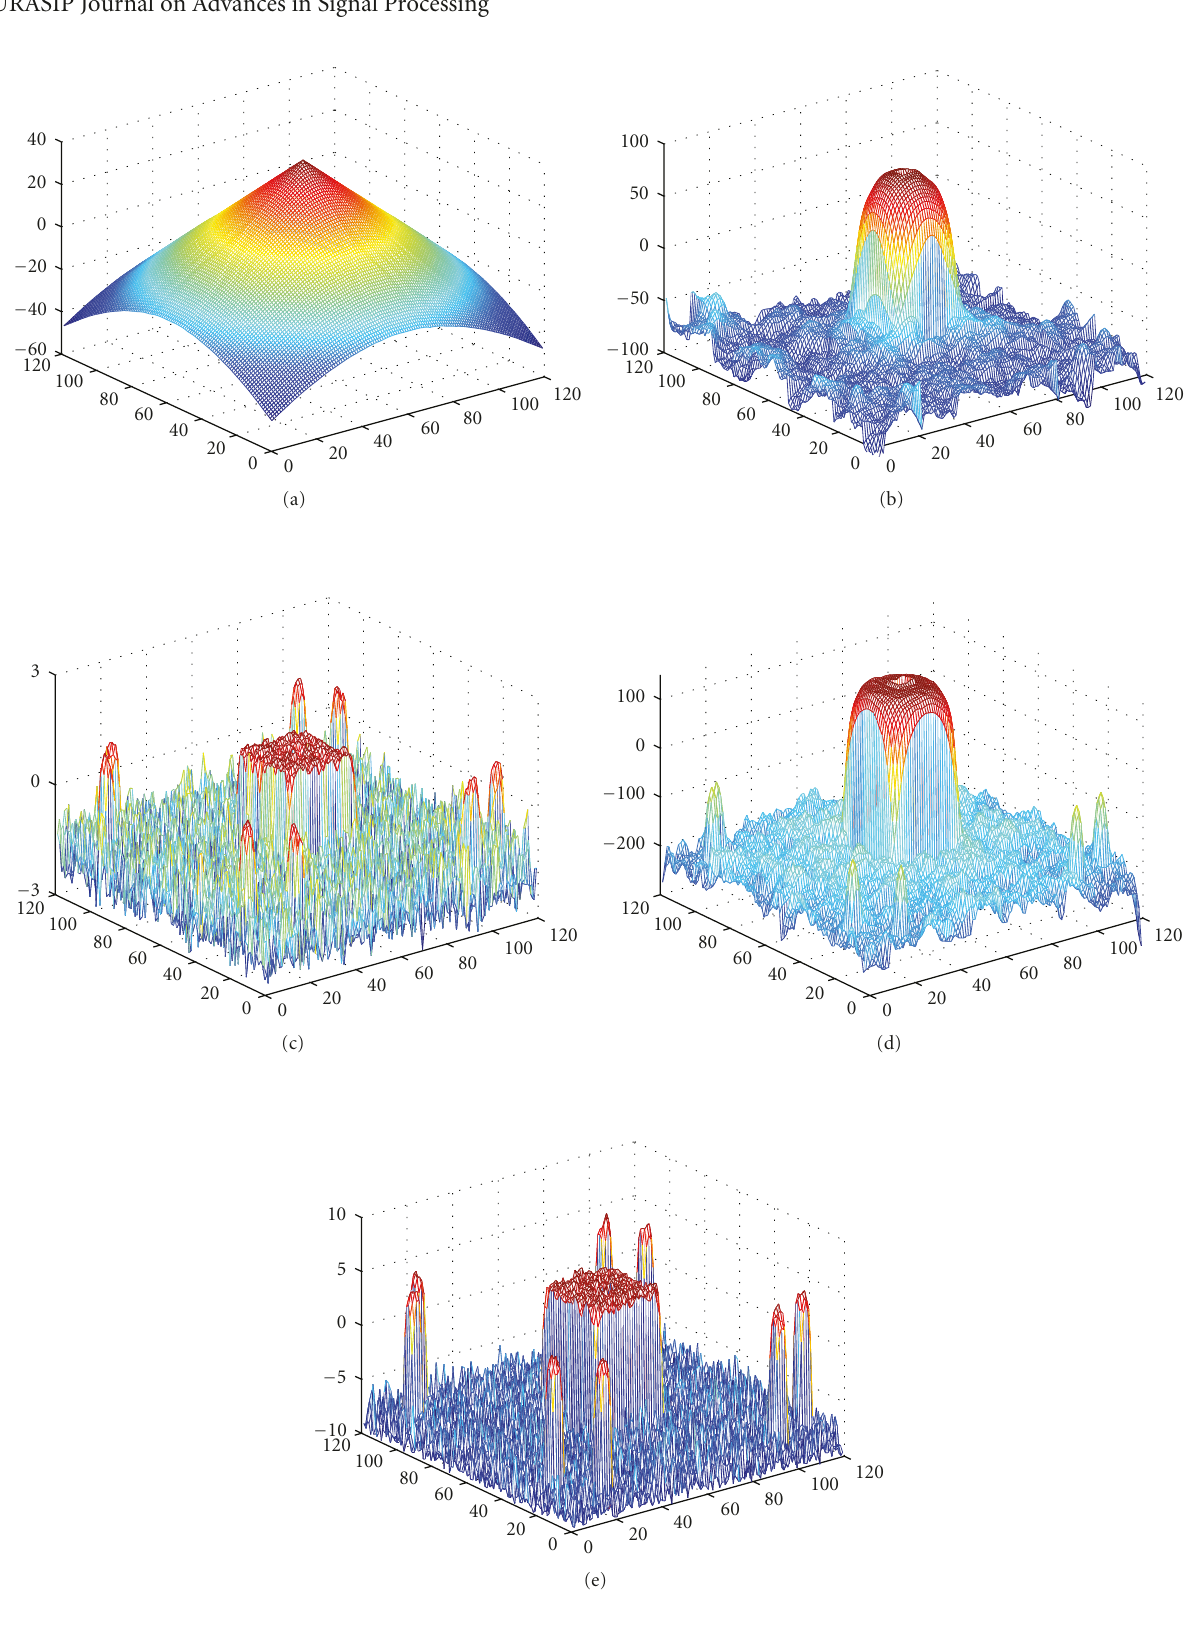
Figure 3: Evolution of the φ function with the method in [10] and our method. (a) Initial φ for the following experiments. (b) Evolution result with the method in [10] for single-look data. (c) Evolution result with our method for single-look data, α = 3. (d) Evolution result with the method in [10] for 4-look data. (e) Evolution result with our method for single-look data, α =